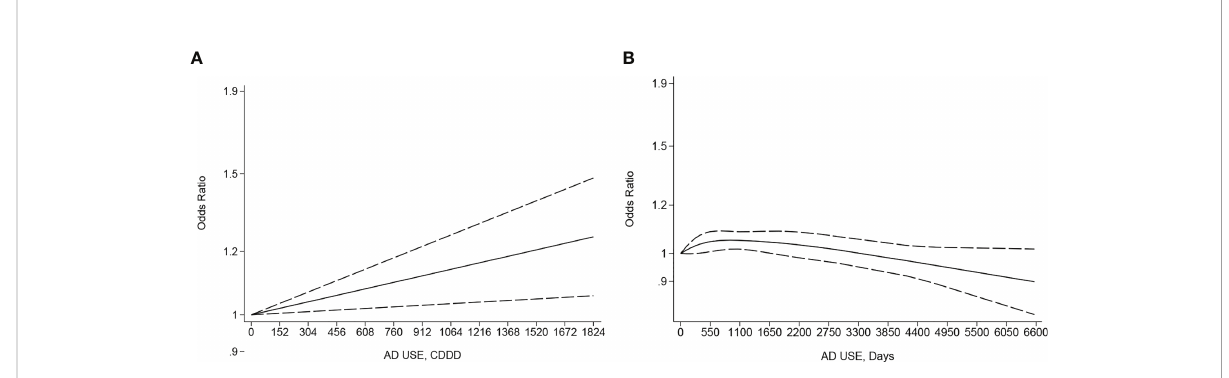
FIGURE 3 (A) Dose – response for cumulative de fi ned daily dose (CDDD) of antidepressant (AD) use and incidence risk of breast cancer. (B) Dose – response for duration of antidepressant use and incidence risk of breast cancer. The black solid line and the black long dashed line represent the